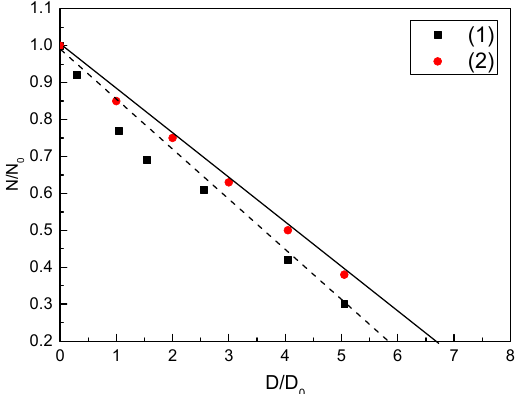
Figure 2. Normalized dependences of the electron concentration on irradiation dose: (1) 3 C -SiC/6 H -SiC structures, D 0 = 1 × 10 12 cm − 2 , N 0 = 8 × 10 14 cm − 3 , (2) 4 Н -SiC epitaxial layers, D 0 = 1 × 10 15 cm − 2 , N 0 = 6.5 × 10 17 cm − 3 .